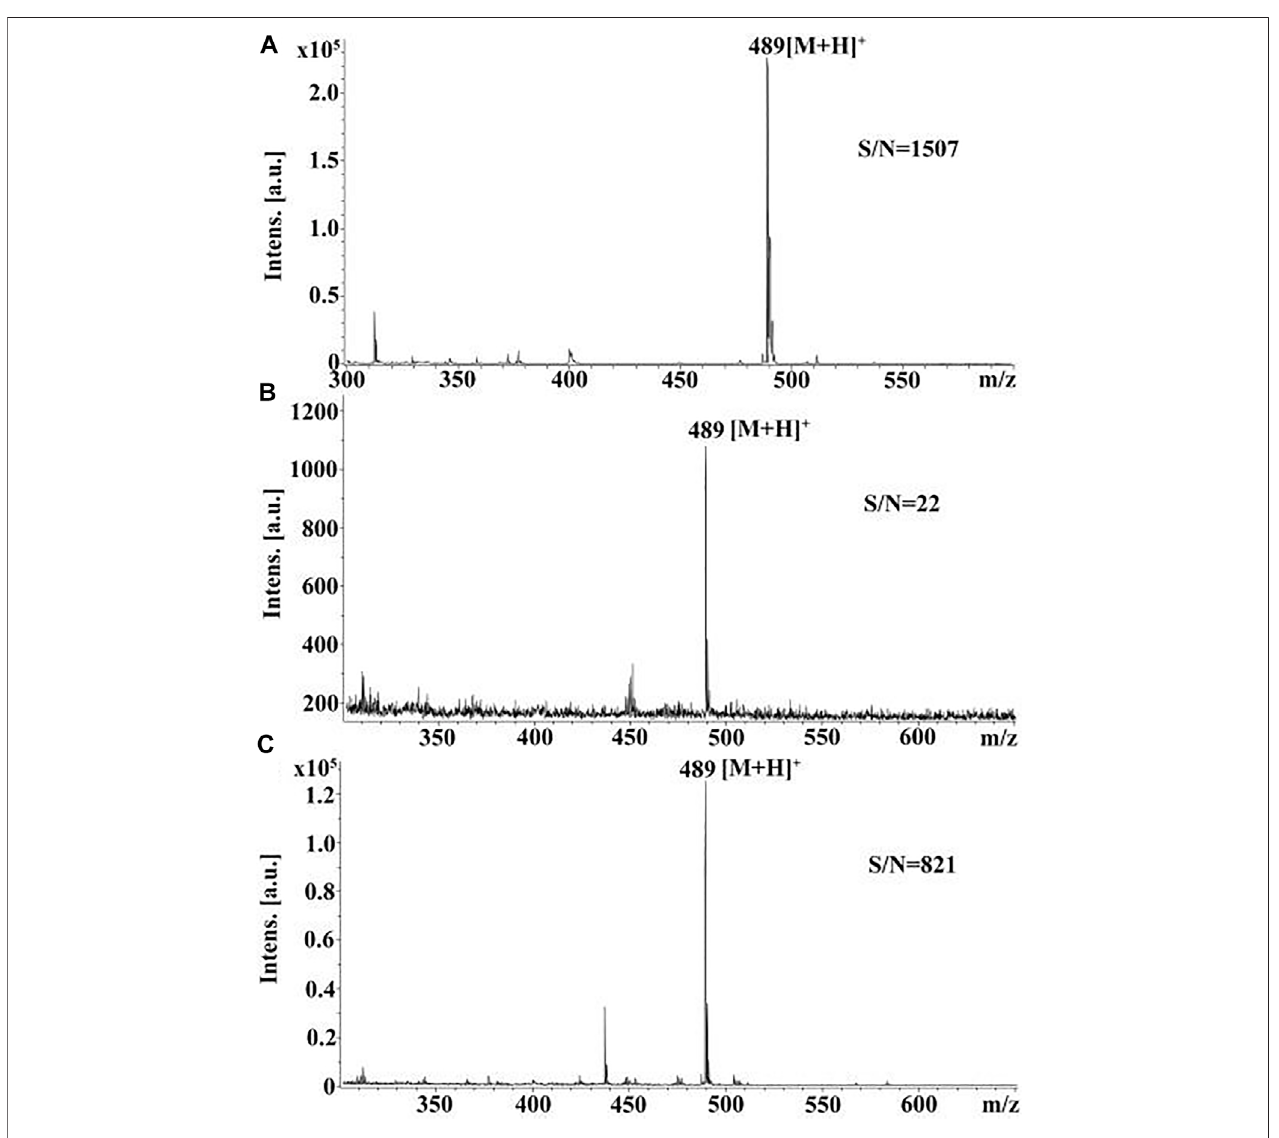
FIGURE 3 | MALDImass spectra of vardena fi l registered from (A) steel MALDI target using ATas the matrix, (B) TLC plate after elution and using AT as the matrix, and (C) TLC plate after elution using the composite matrix (AT-glycerol-graphite). Figure reprinted with permission from Esparza et al. (2016). Copyright (2016) Elsevier B.